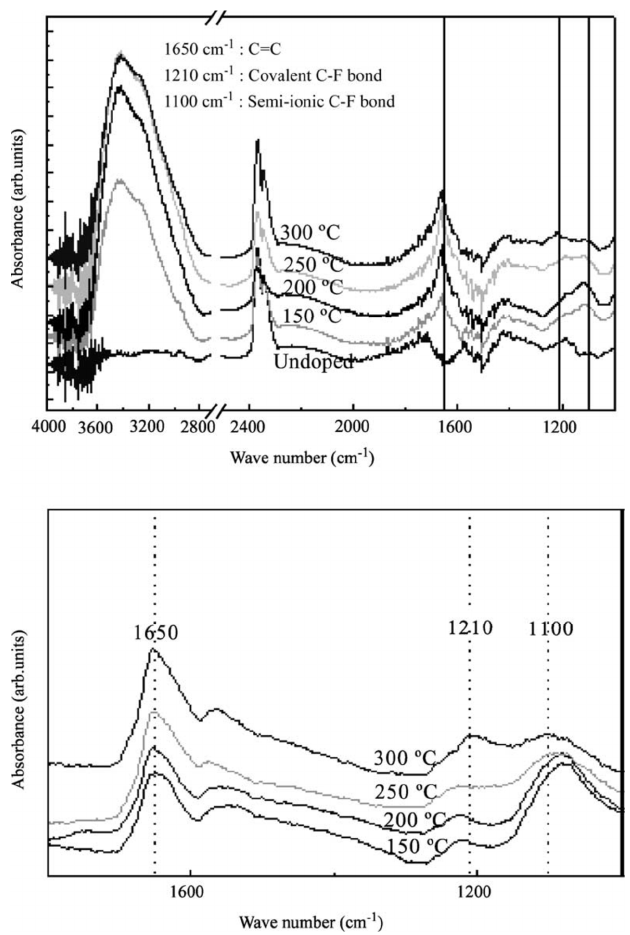
Figure 5. FTIR spectra of pristine SWCNTs and SWCNTs fluorinated at 150, 200, 250 and 300 °C. Reprinted with permission from Ref. [48]. Copyright 2003 Elsevier.